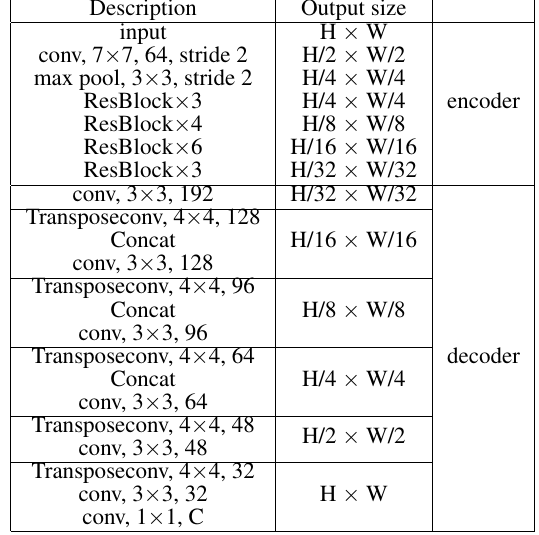
Table 1. U-Net based ResNet50